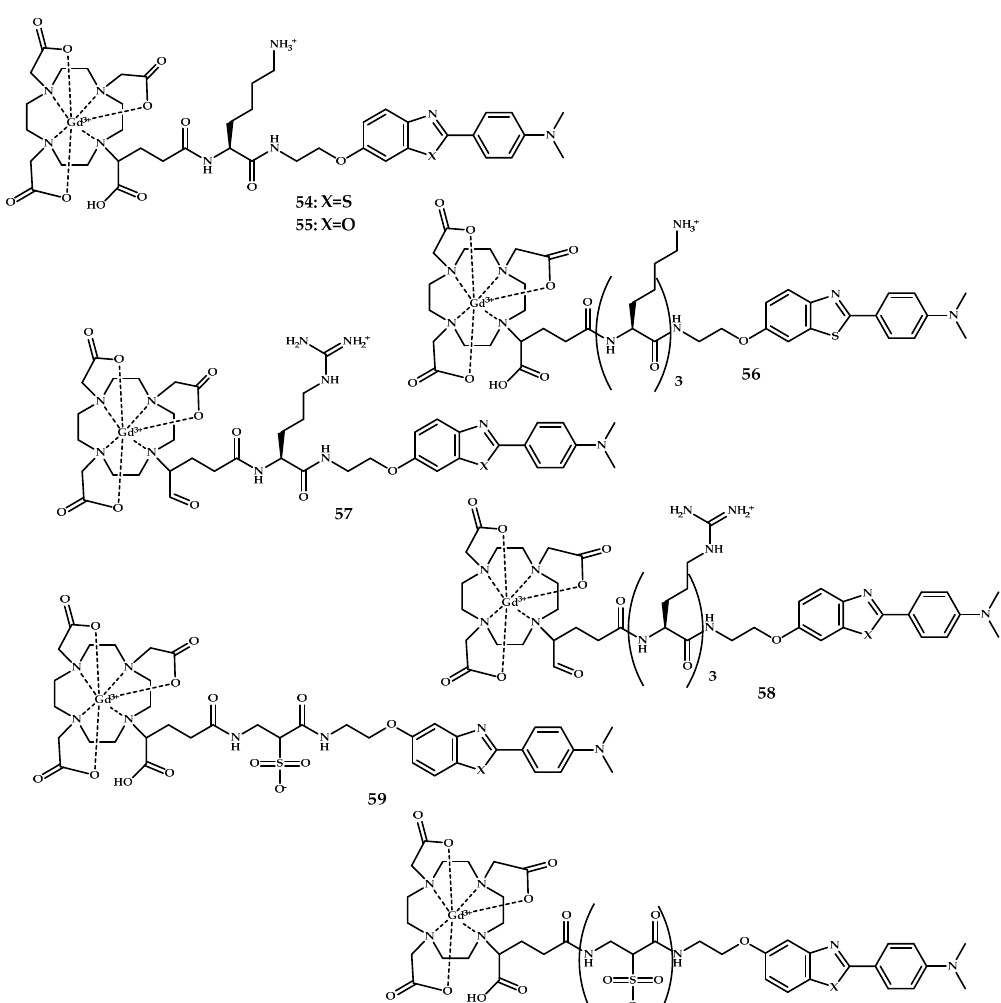
Figure 13. PCTA / DOTA-benzothiazole / benzoxazole / stilbene-based Gd 3 + coordination compounds Figure 13. PCTA/DOTA–benzothiazole/benzoxazole/stilbene-based Gd 3+ coordination compounds 45 – 60 designed for MRI visualization of A β plagues. 45–60 designed for MRI visualization of A β plagues. Int. J. Mol. Sci. 2020 , 21 , x